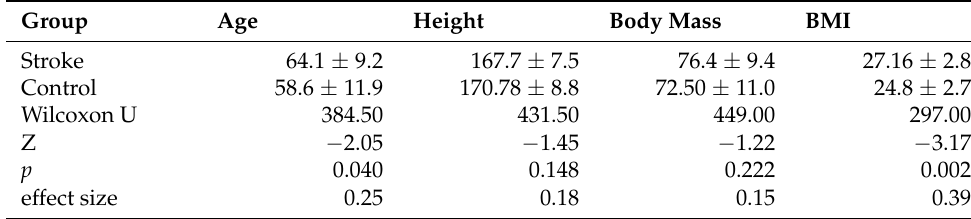
Table 1. Biometric data of study population and clinical control